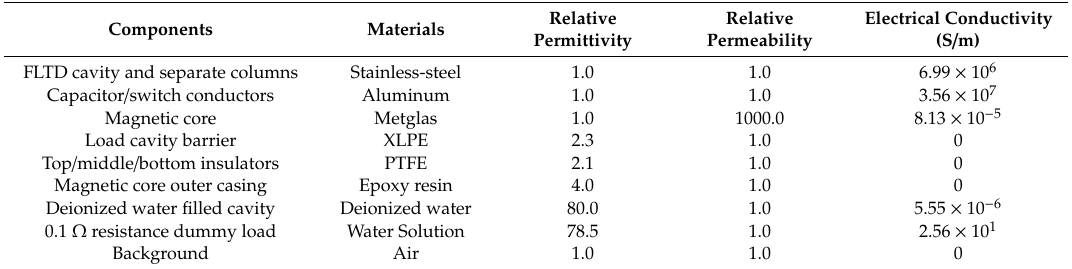
Table 1. Typical value of material characteristics in numerical calculations.